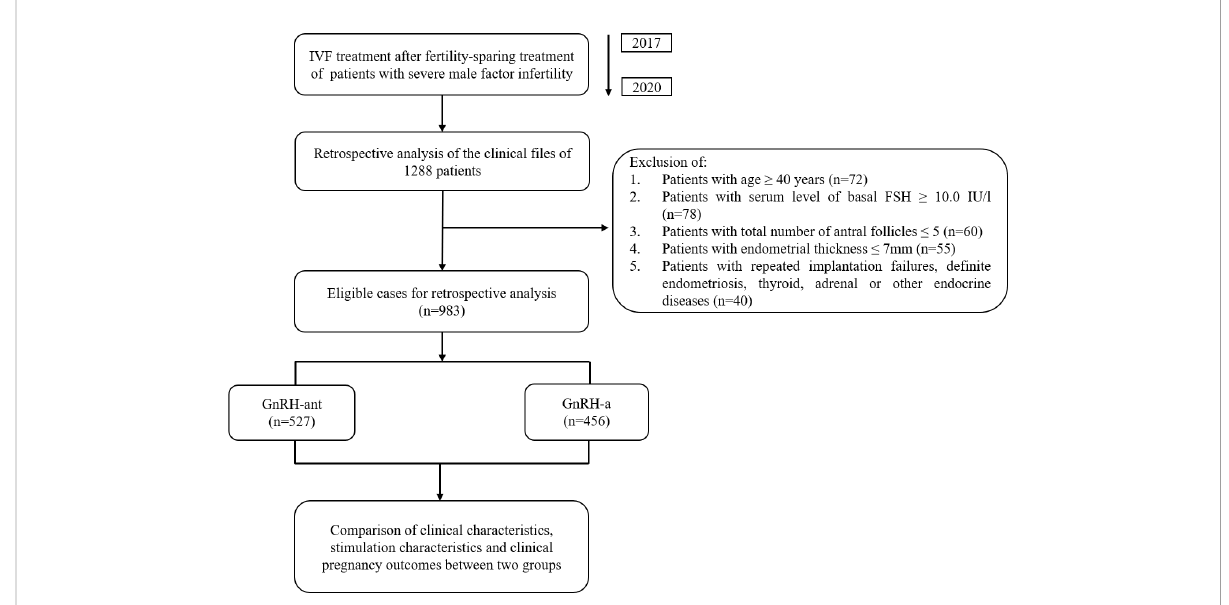
FIGURE 1 Flowchart summarizing the design of the present retrospective